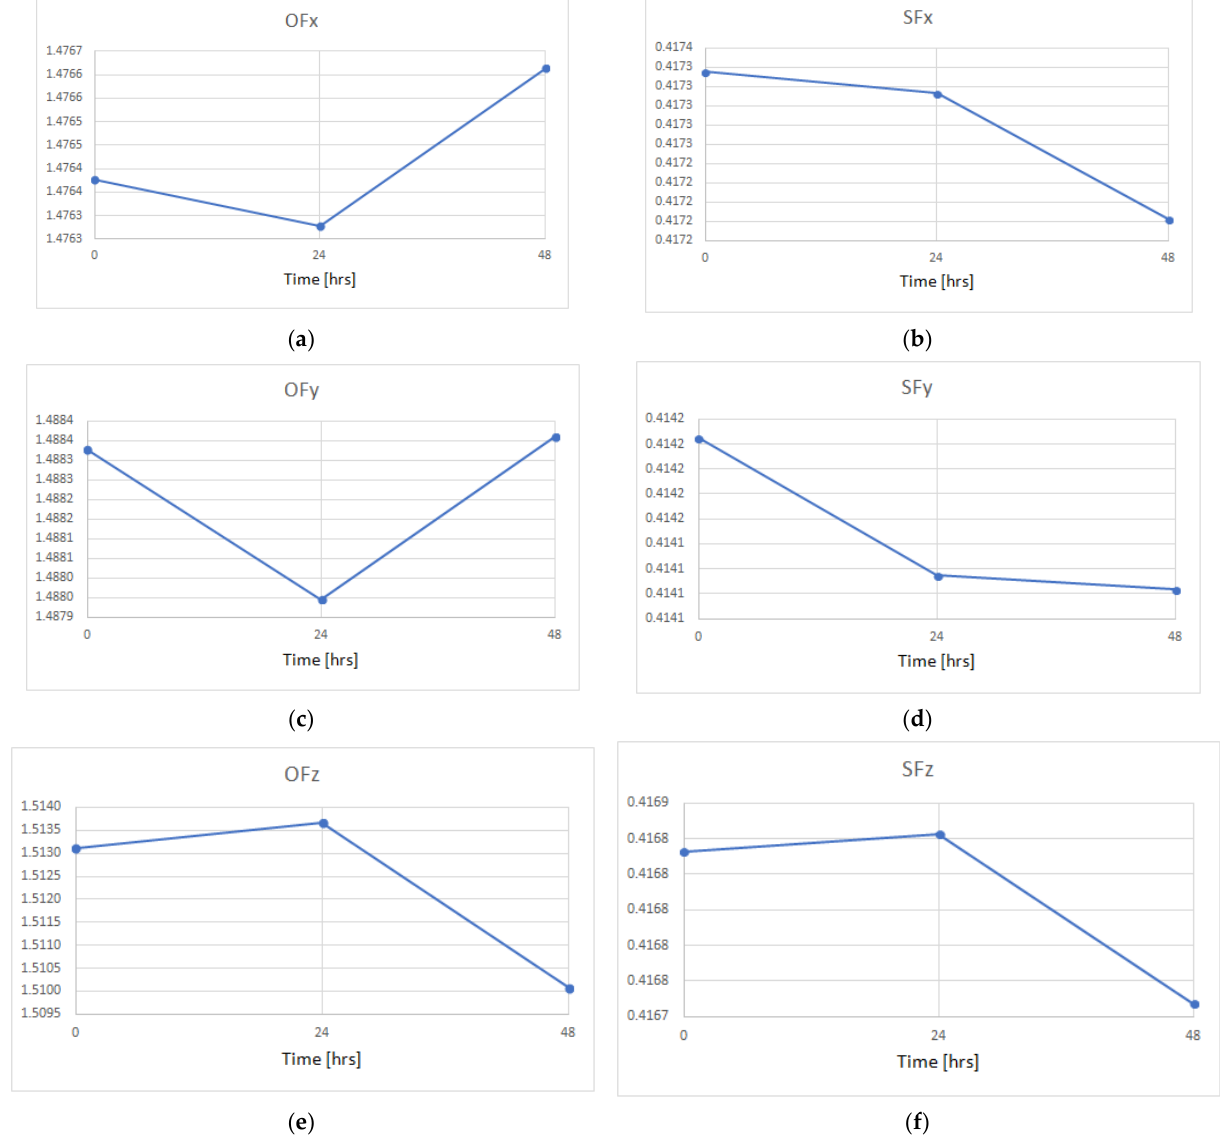
Figure 7. Long-term drifts of the offset and the scale factor over 48 h: ( a ) offset of x -axis; ( b ) scale factor of x -axis; ( c ) offset of y -axis; ( d ) scale factor of y -axis; ( e ) offset of z -axis; ( f ) scale factor of z -axis.